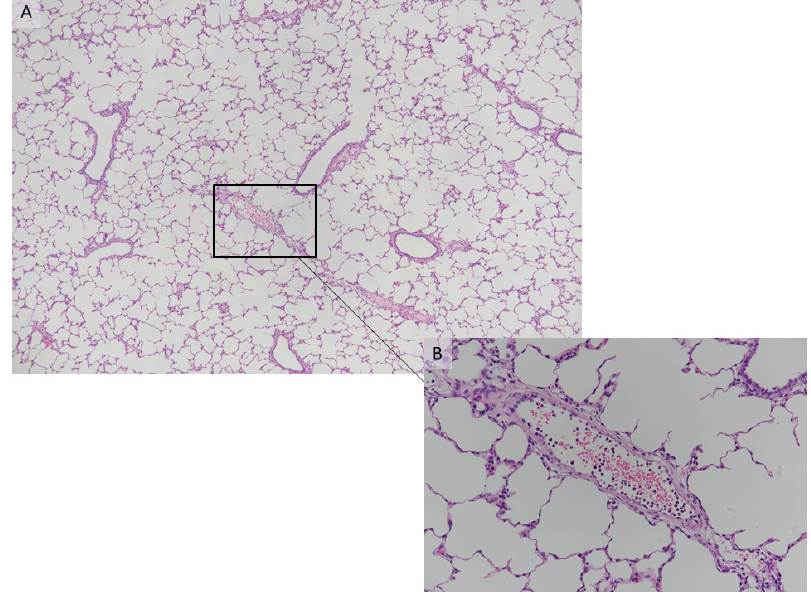
significant (Figure 8A). Blood vessels showed a small number of neutrophils in the lumen and